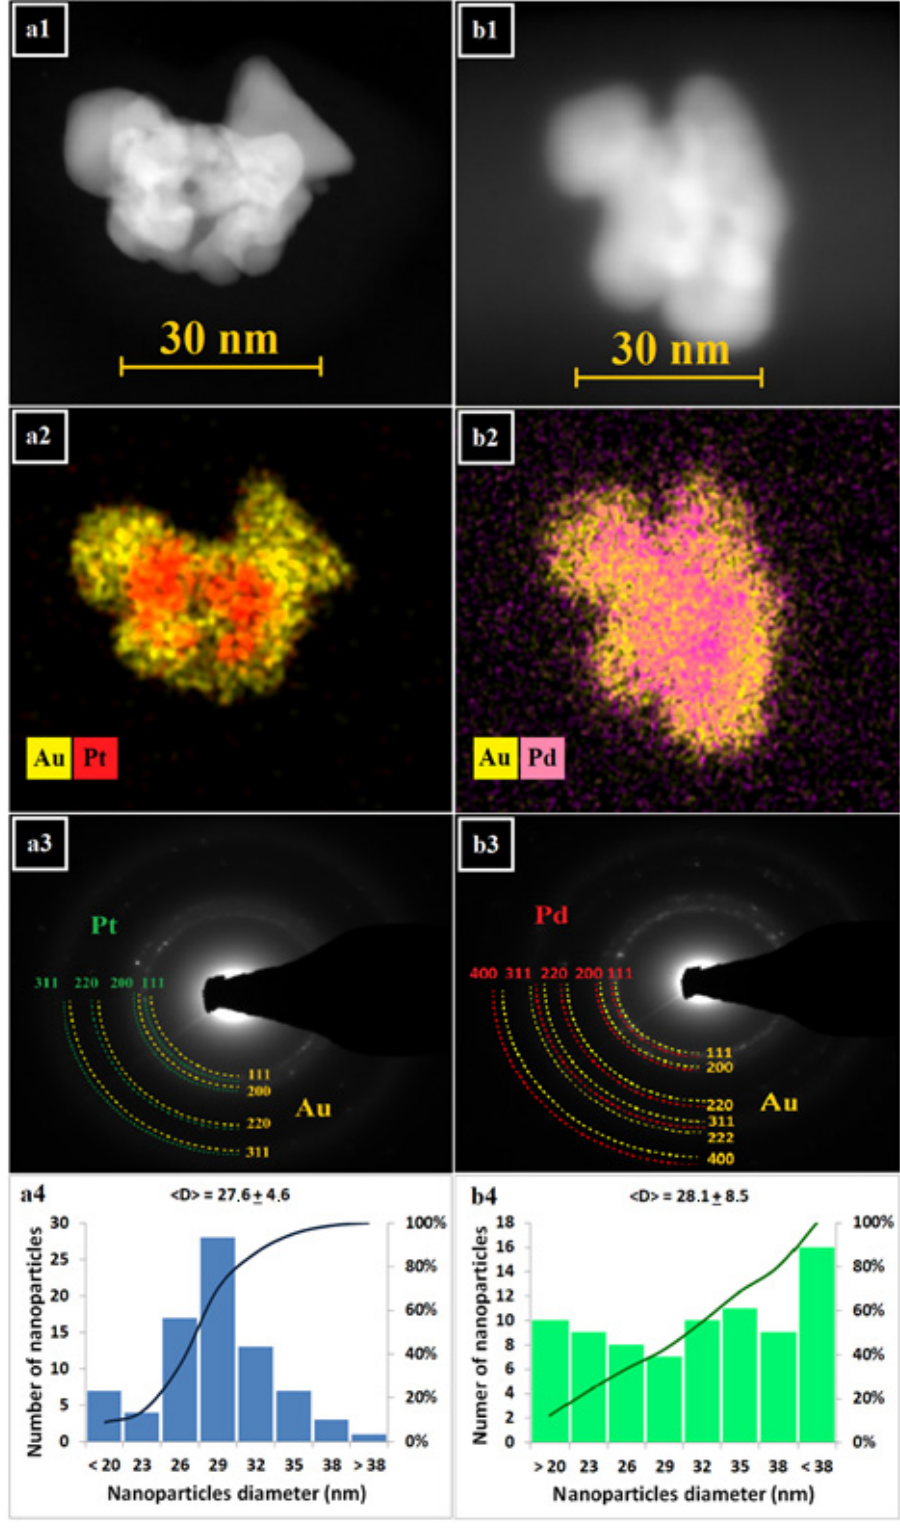
Figure 3. Scanning transmission electron microscopy (STEM), high-angle annular dark-field (HAADF) detector images ( a1 , b1 ), corresponding energy dispersive X-ray spectroscopy (EDS) distribution maps ( a2 , b2 ), selected area electron diffraction (SAED) patterns ( a3 , b3 ) and size distribution (histograms and distribution curves; ( a4 , b4 ) of PtAu ( a ) and PdAu NPs ( b ).